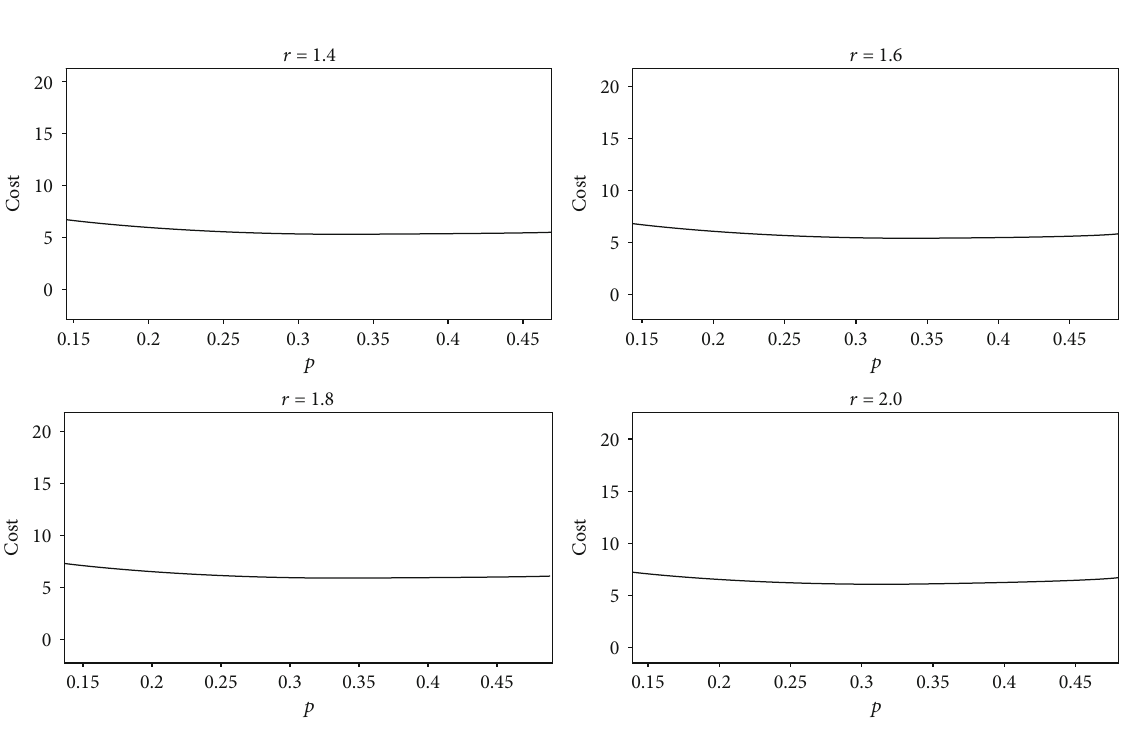
Figure 12: The relationship between cost and p .